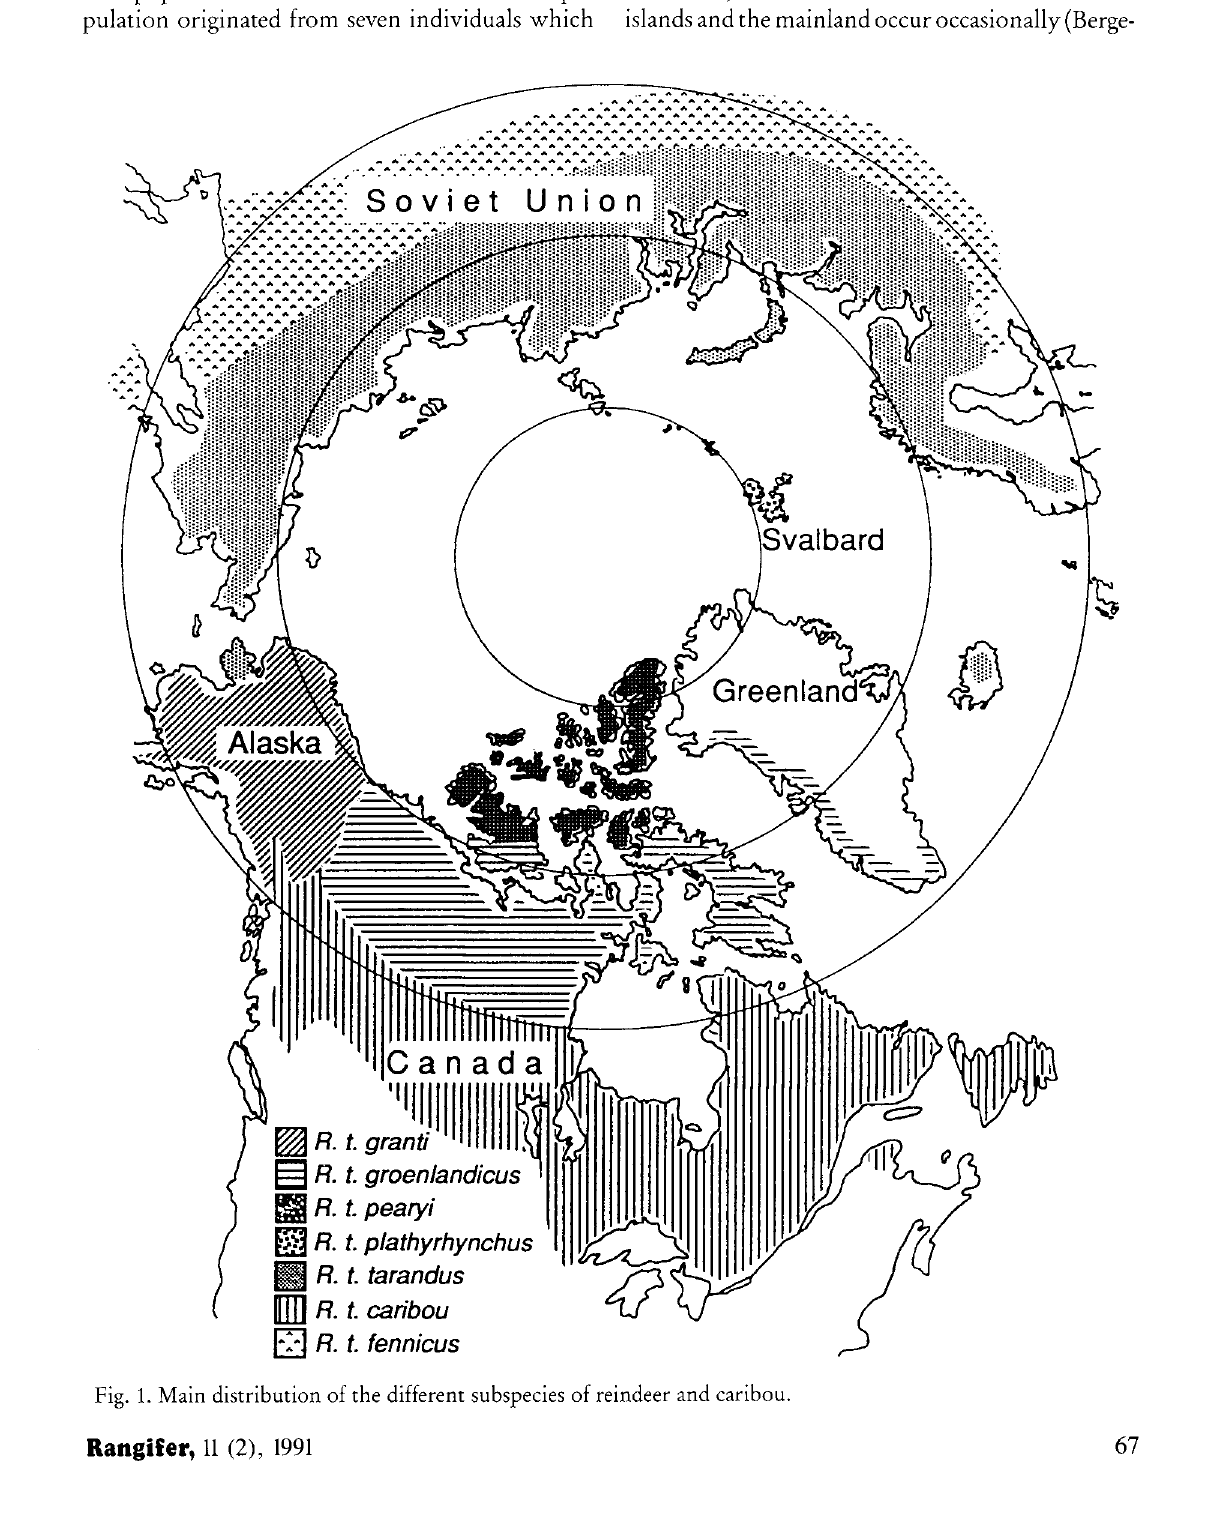
Fig. 1. Main distribution of the different subspecies of reindeer and